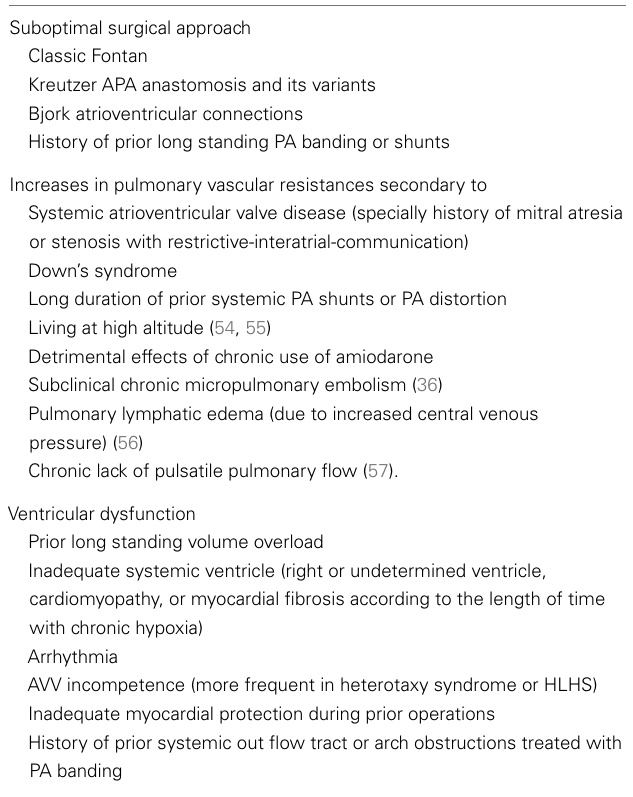
Table 1 | Factors that jeopardize the late outcome after a Fontan Kreutzer